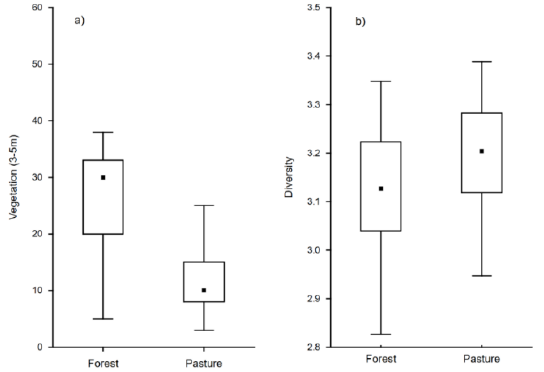
Figure 2. Differences in vegetation density ( a ) and species diversity ( b ) between both forest and pasture habitats. Points — medians, rectangles — 25 – 75% of data, whiskers — non-outlier range. We recorded a total of 1603 individual birds across 44 sampling points with 85 spe- The differences in bird abundances when comparing the field abundance versus corrected abundances by distance sampling are illustrated in Supplementary Table S1. cies recorded. Of these, there were 34 families, mostly dominated by Pycnonotidae (23.5%), Nectariniidae (17.6%), and Cisticolidae (14.7%) each; the most commonly rec-